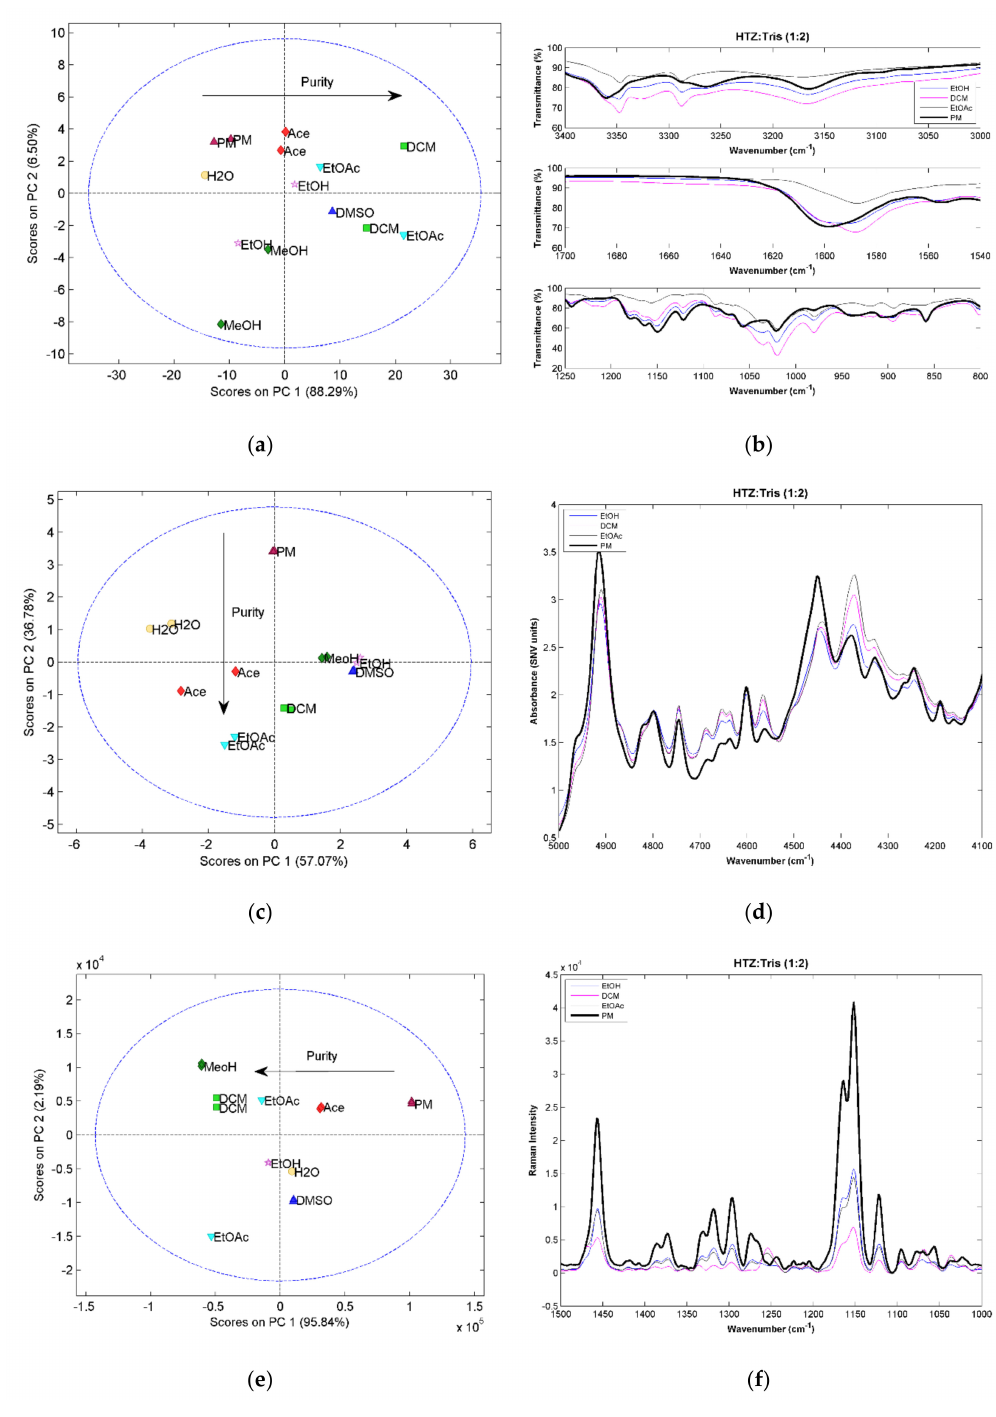
Figure 2. ( a ) PCA score plot constructed with the MIRS spectra from the system HTZ:Tris (1:2); ( b ) MIRS spectra of the samples produced with EtOH, DCM, and EtOAc and from the PM; ( c ) PCA score plot constructed with the NIRS spectra from the system HTZ:Tris (1:2); ( d ) NIRS spectra of the samples produced with EtOH, DCM, and EtOAc and from the PM; ( e ) PCA score plot constructed with the RS spectra from the system HTZ:Tris (1:2); ( f ) RS spectra of the samples produced with EtOH, DCM, and EtOAc and from the PM. Colors refer to different solvents (dark green: MeOH; pink: EtOH; red: Ace; green: DCM; dark blue: DMSO; blue: EtOAc; yellow: H 2 O; dark red: